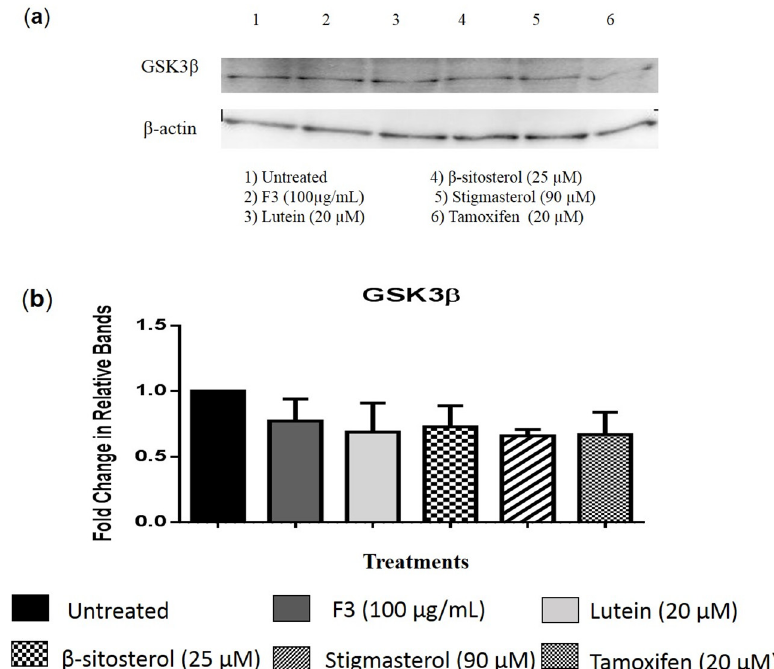
Figure 10. GSK3 β protein expression. ( a ) Representative image of Western blot analysis of MDA-MB-231 cells treated with the indicated concentrations of (2) F3, (3) lutein, (4) β -sitosterol, (5) stigmasterol, and (6) tamoxifen (positive control), while (1) untreated as a negative control for 24 h. ( b ) Results are presented as an average fold change in the level of each protein normalized to β -actin ± SD ( n = 3).